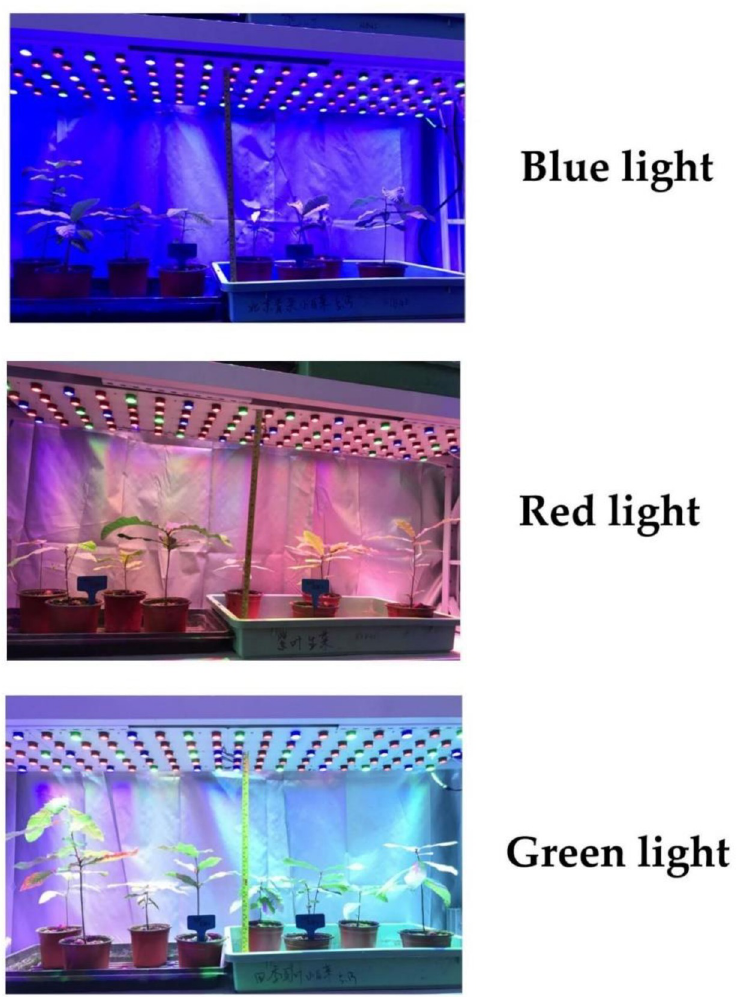
Fig 1. Typical performance of Chinese cork oak ( Quercus variabilis Blume) seedlings exposed to blue (48.5% blue, 33.7% green, and 17.8% red), red (14.6% blue, 71.7% red, and 13.7% green), and green (17.4% blue, 26.2% red, 56.4% green) colors of light-emitting diode (LED) spectra. Tanks for potted seedlings were 40 × 60 cm. Green tanks contained seedlings subjected to 15 N pulses and black tanks contained seedlings subjected to water addition of the same